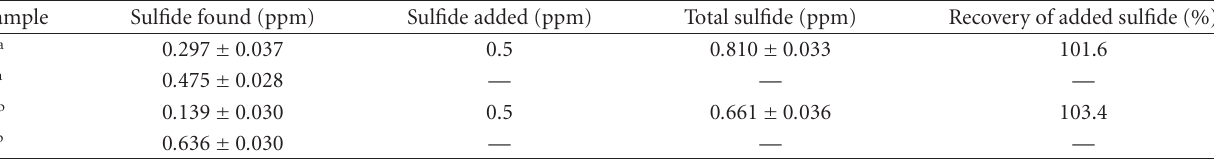
Table 4: Determination of dissolved sulfide from bore well and pond water samples using extraction procedure.